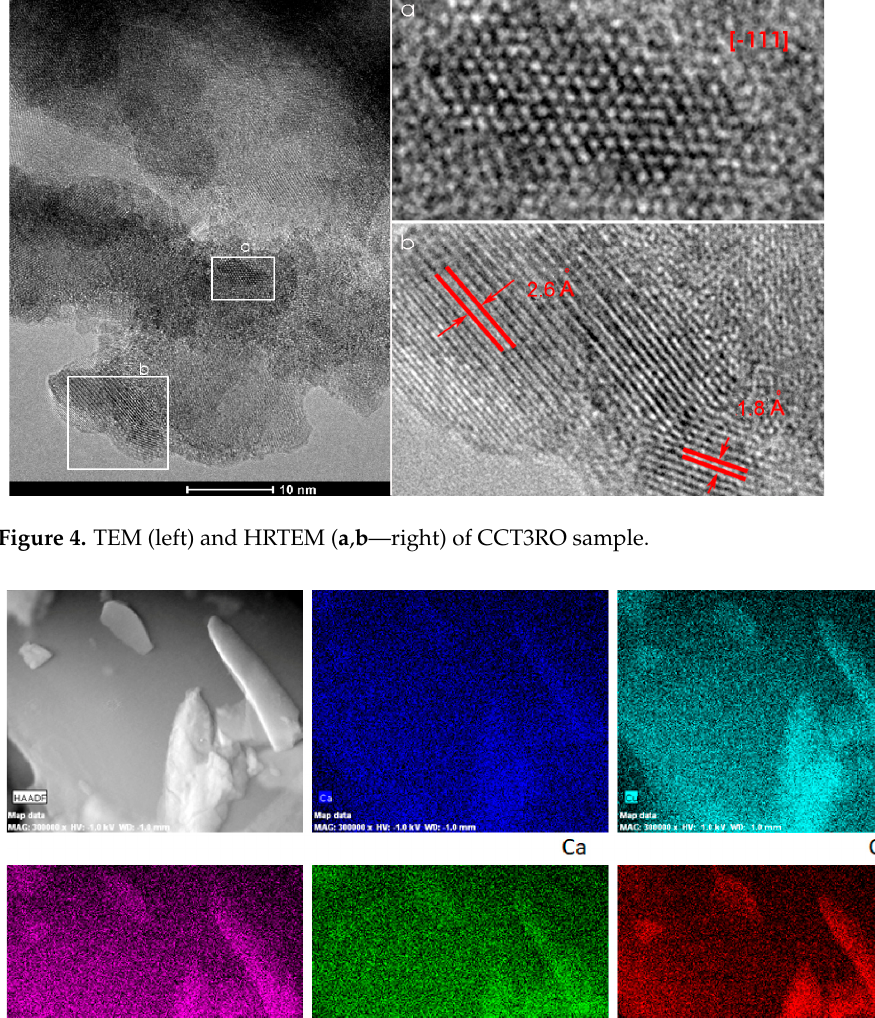
Figure 5. ADF/STEM analysis and EDXS elemental mapping of CCT3RO powder.